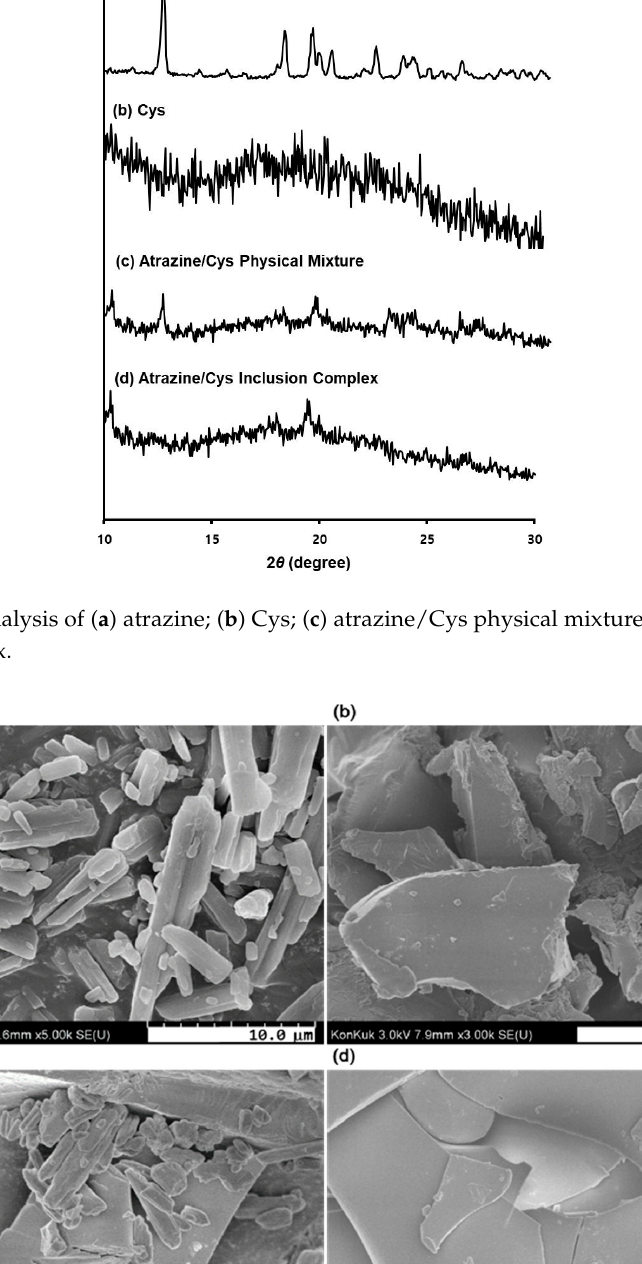
Figure 6. XRD analysis of ( a ) atrazine; ( b ) Cys; ( c ) atrazine/Cys physical mixture; ( d ) atrazine/Cys inclusion complex.